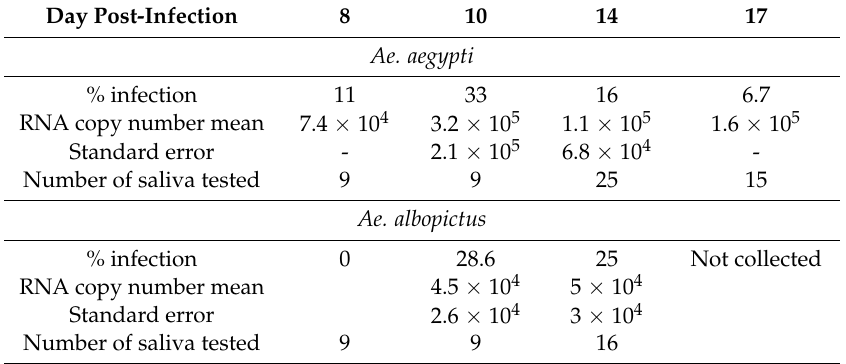
Table 1. Rate of transmission of ZIKV by Aedes mosquitoes at different times post-infection.